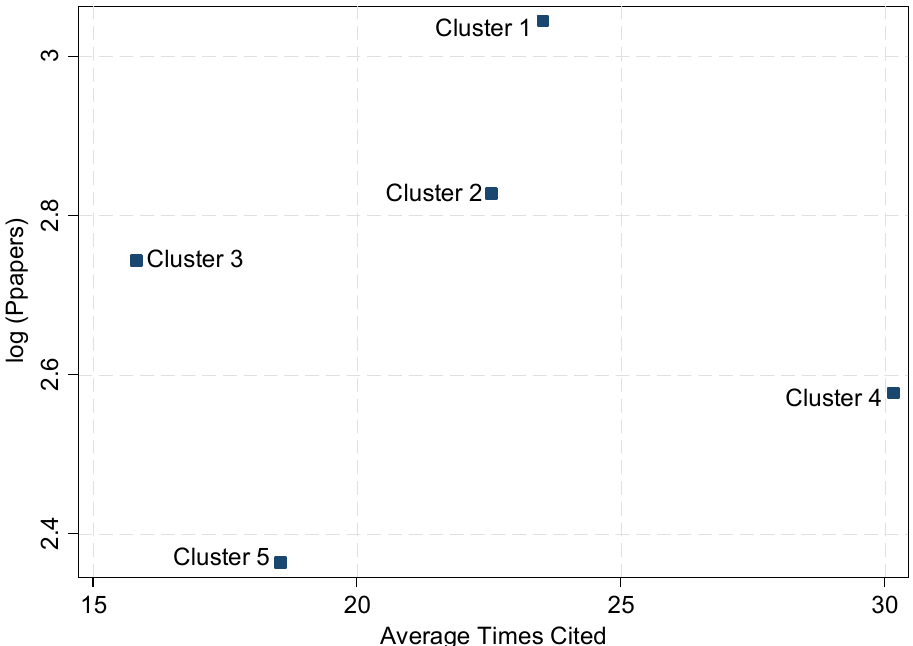
Figure 6. Analysis of streams of research on the most prominent keywords.